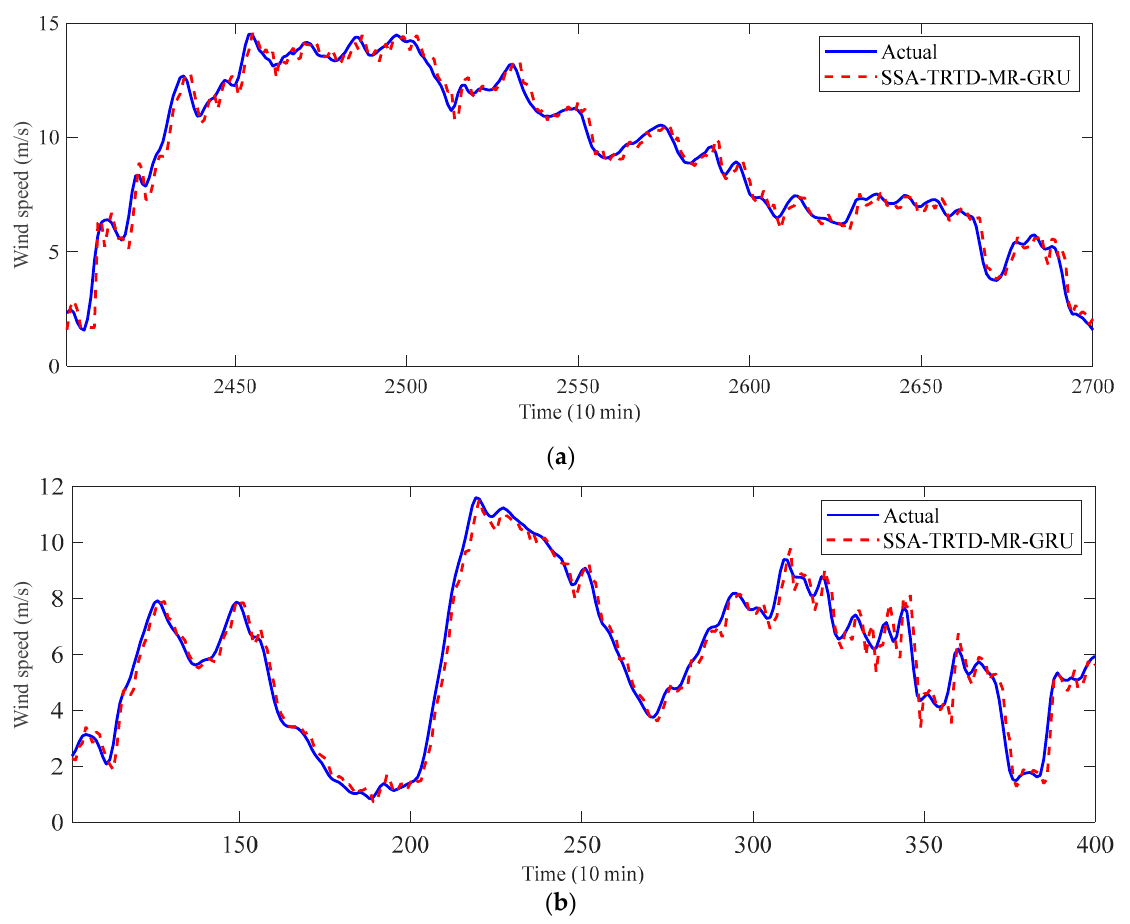
Figure 9. Typical prediction of testing sets of A2018 and B2019 by the proposed model: ( a ) A2018; ( b ) B2019. Table 4. The summary of prediction accuracies of